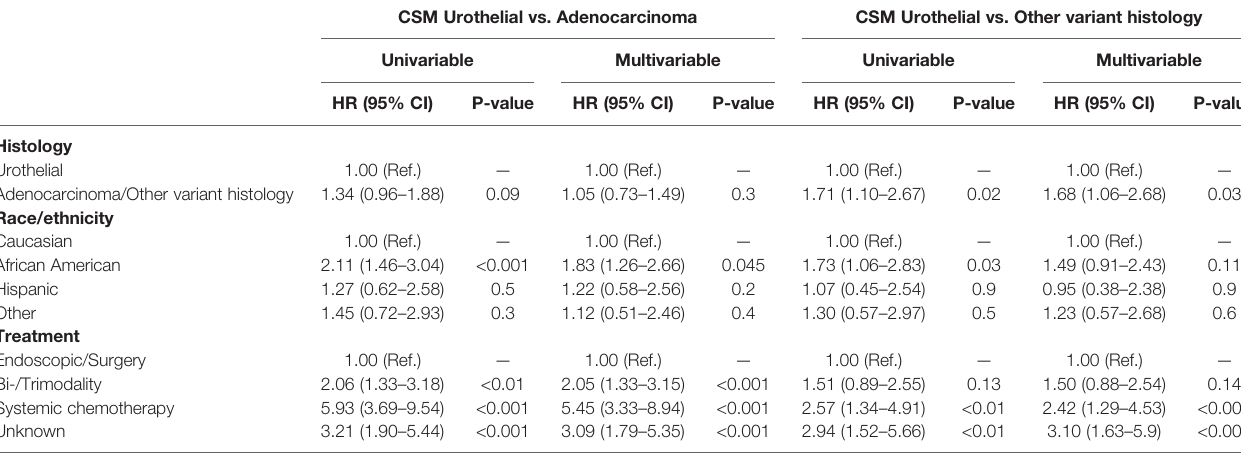
TABLE 3 | Univariable and multivariable competing-risks regression models for urethral cancer patients (Urothelial vs. Adenocarcinoma/Urothelial vs. Other variant histology).